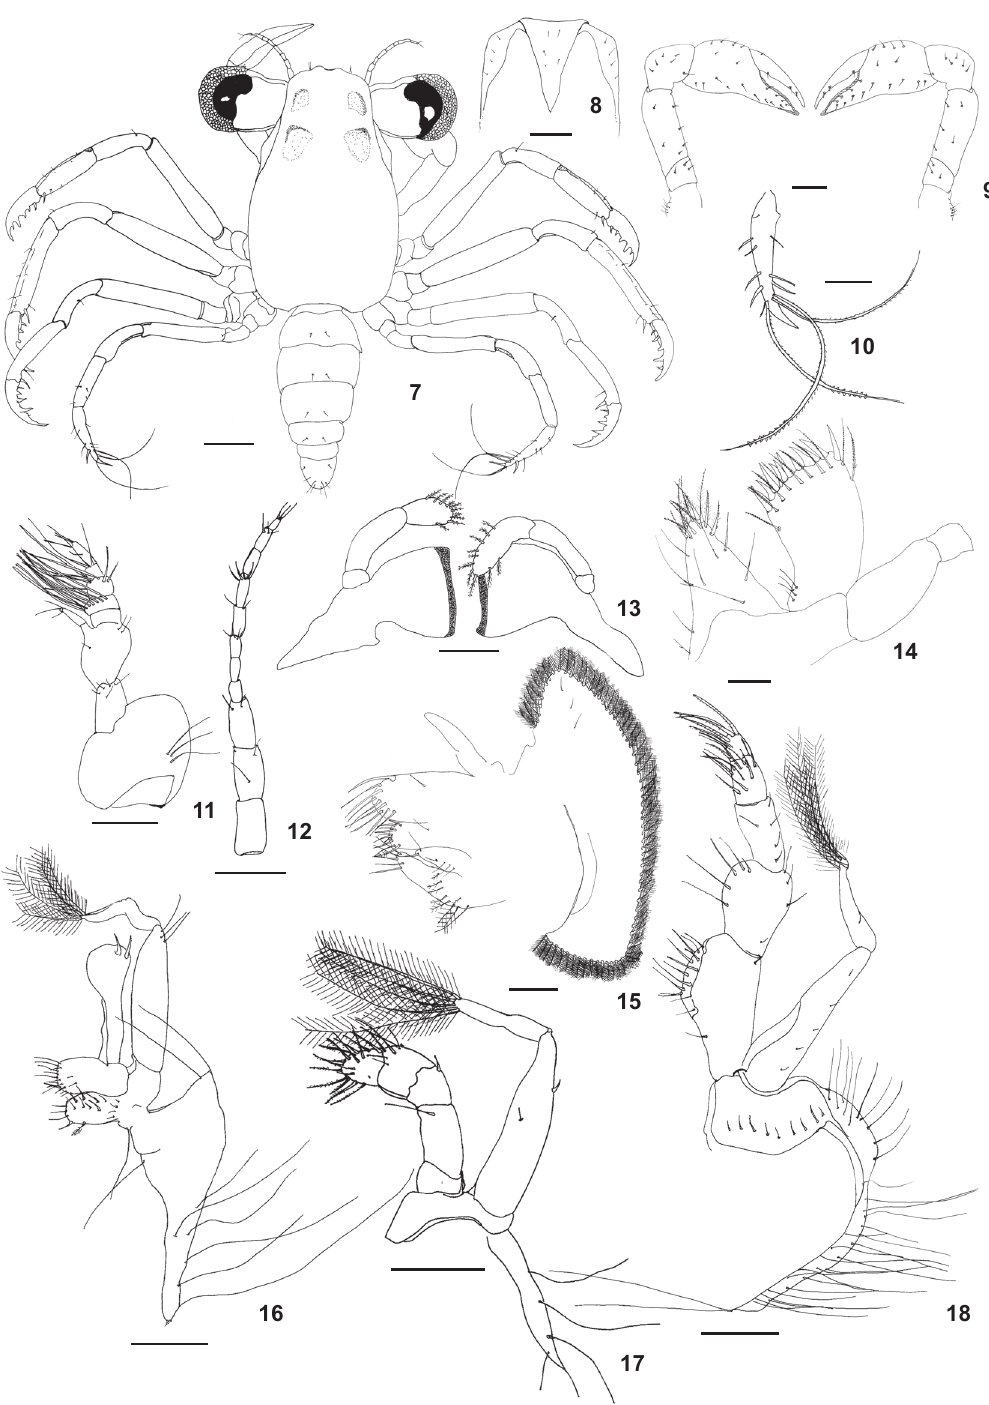
Figures 7-18. Pachygrapsus gracilis , megalopa appendages: (7) dorsal view; (8) ventral view of carapace showing detail of rostrum; (9) quelipods; (10) dactyl of pereiopod 5; (10) antennule; (10) antenna; (11) mandible (12) maxillule; (13) maxilla; (14) 1 st maxilliped; (15) 2 nd maxilliped; (16) 3 rd maxilliped. Scale bars: 7 = 0.02 mm; 8-11, 15-18 = 0.01 mm; 13 = 0.006 mm; 14 = 0.08